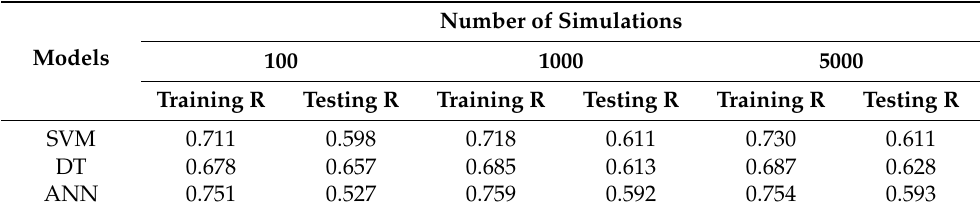
Table 3. Sensitivity analysis for number of simulations.